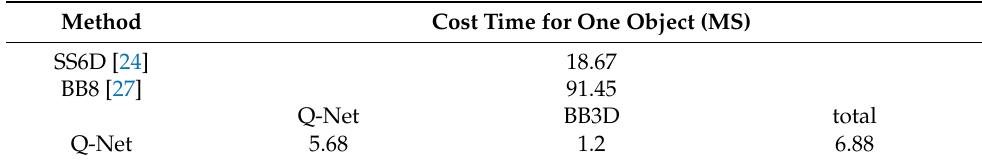
Table 5. Cost time comparison for LineMod